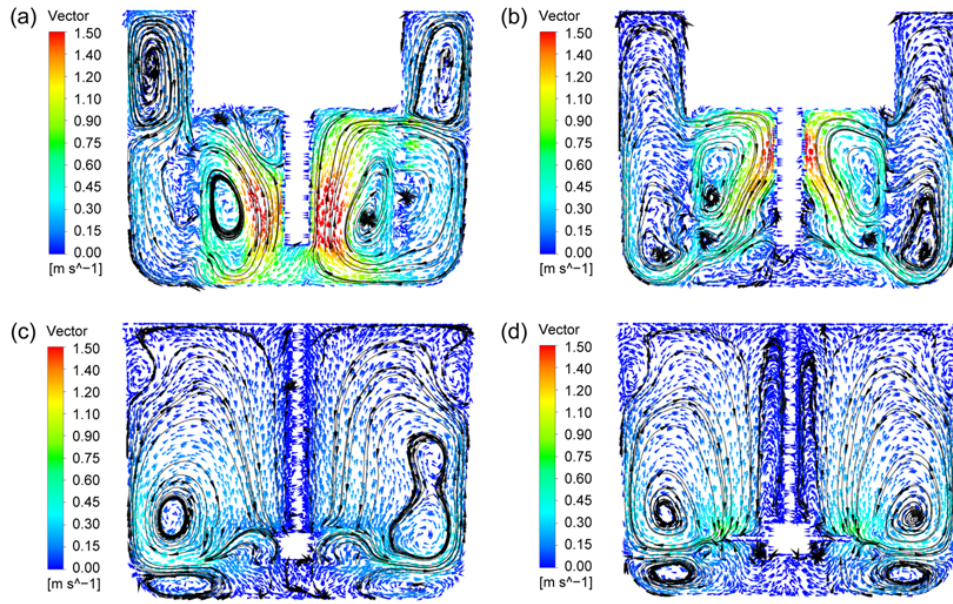
Figure 5. Velocity vectors of solid particles for the four types of agitators at the stirring speed of 400 rpm; ( a ) CSRS agitator; ( b ) HCSRS agitator; ( c ) A200 agitator; ( d ) Rushton agitator.